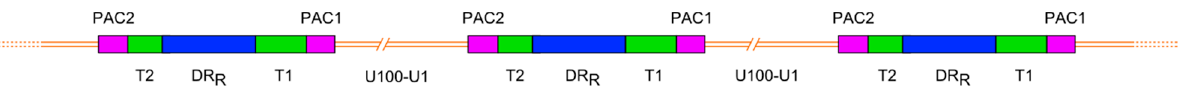
Figure 3. Diagram showing concatemers that would rise form rolling circle replication of a HHV-6 genome that had been excised from a telomere following t-loop formation.